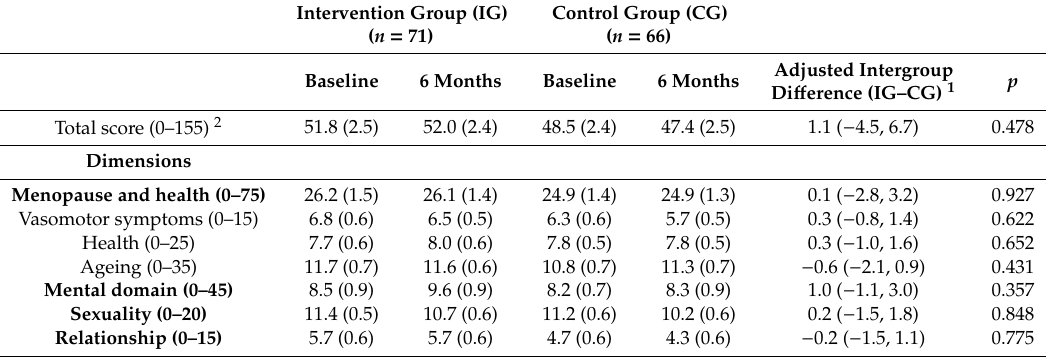
Table 4. Changes in the Cervantes scale score and dimensions in postmenopausal women